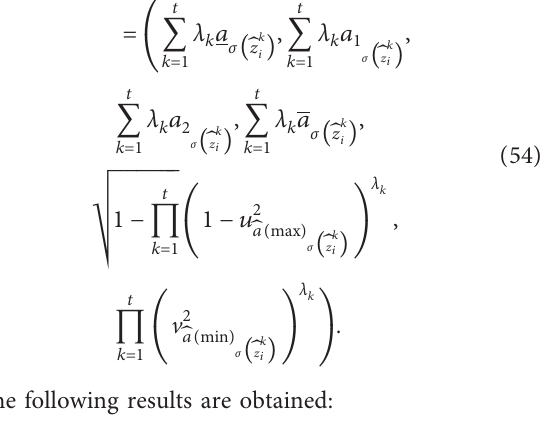
Figure 8: The comparison analysis results with different